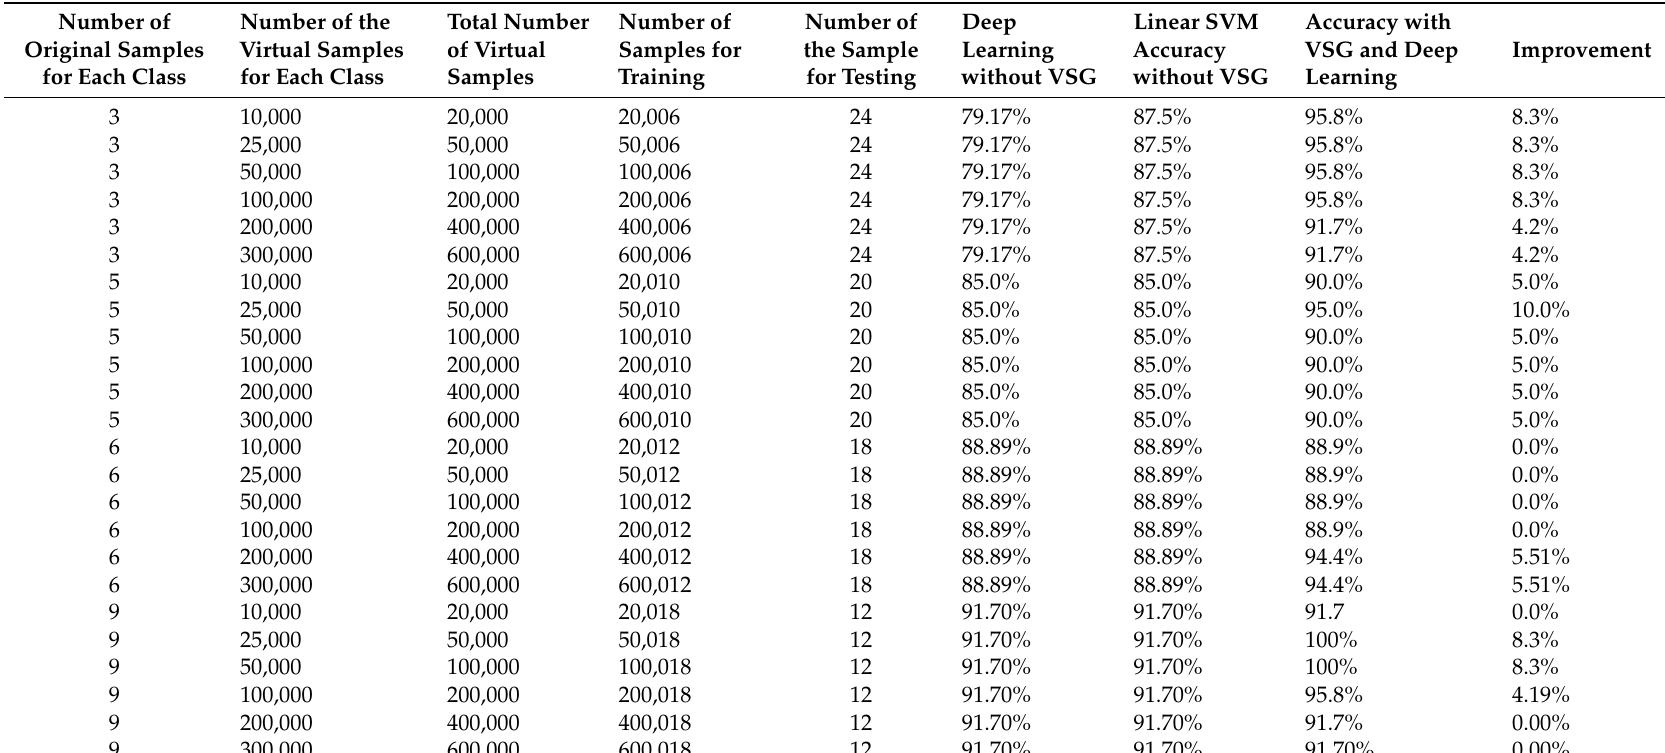
Table 4. The results of the average accuracy using the Breast Tissue